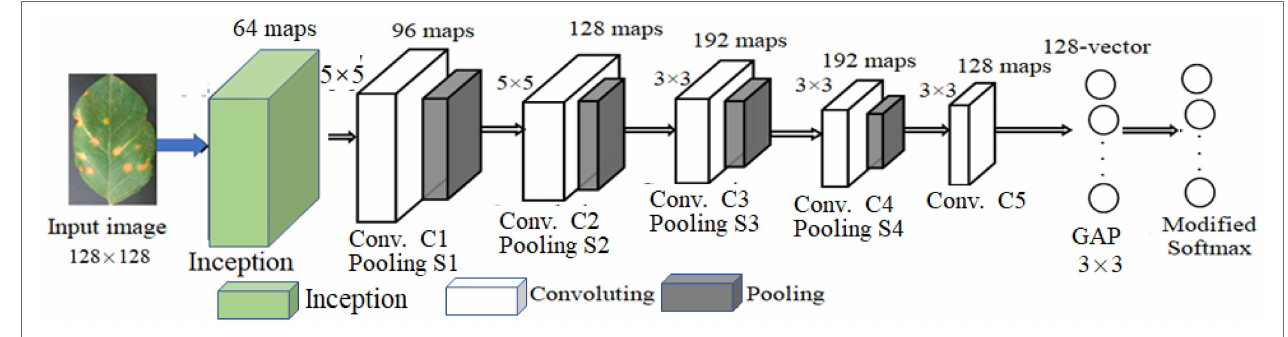
FIGURE 4 | Architecture of modified convolutional neural networks (MCNN).